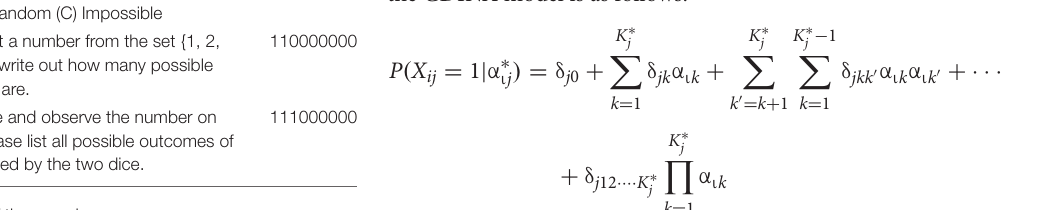
TABLE 4 | Structure description of the